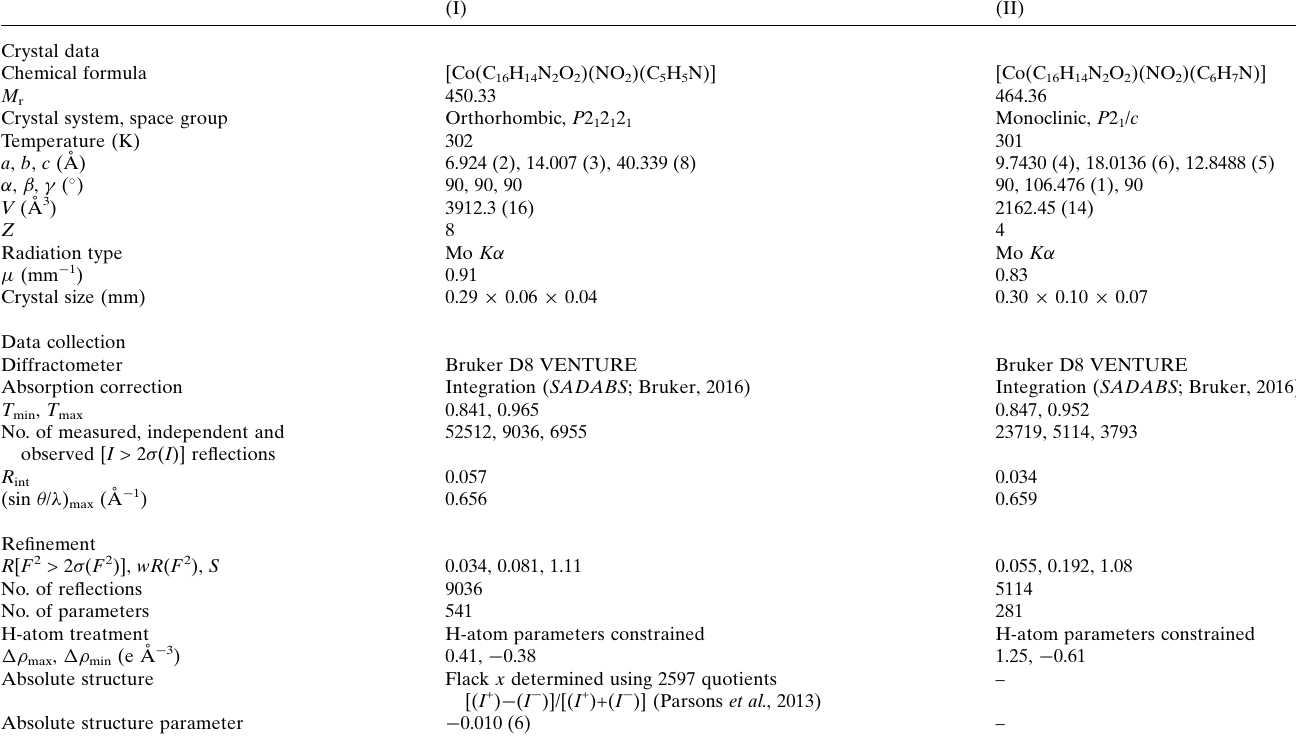
Table 3 Experimental